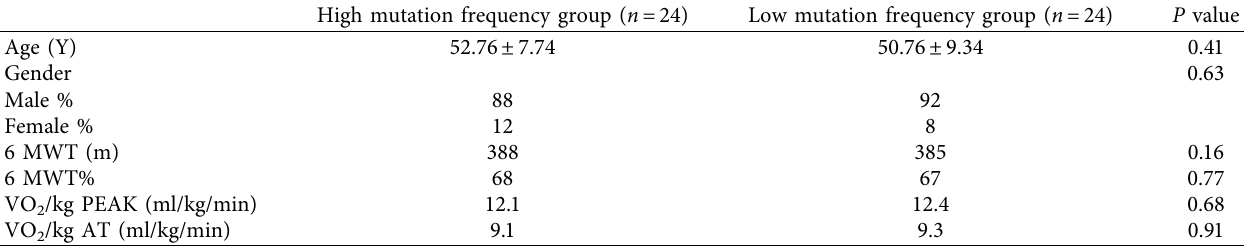
Figure 3: Intervention flow chart. Table 2: Comparison of baseline indexes between the high mutation frequency group and the low mutation frequency group.